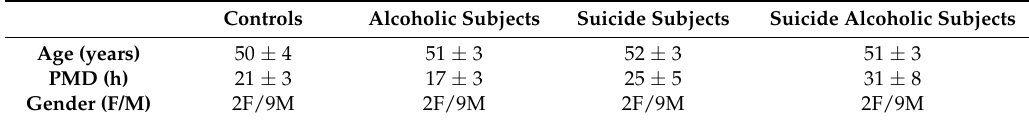
Table 2. Means and gender distribution of the demographic characteristics of the subjects